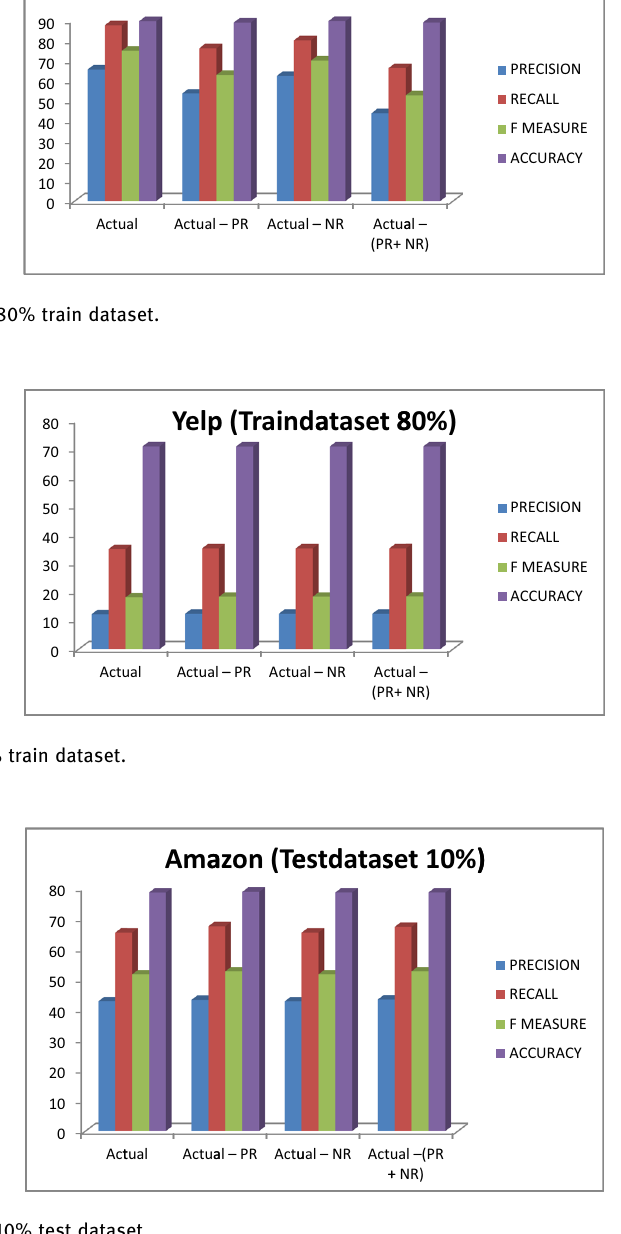
Figure 8: Plot for Amazon 10% test